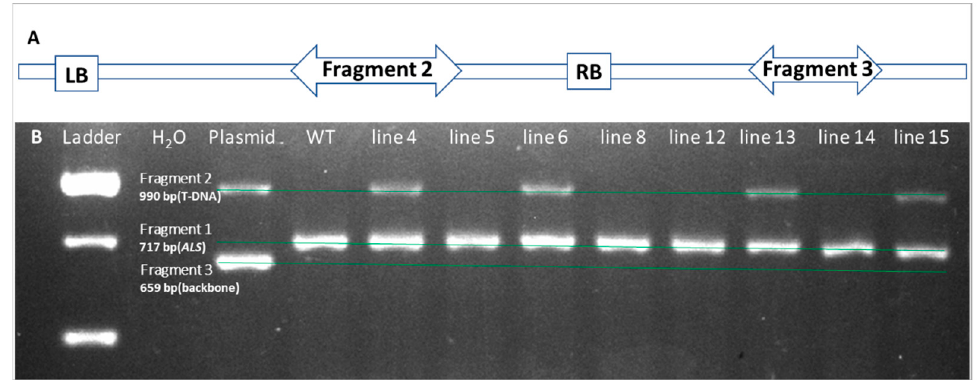
Figure 4. PCR confirmation of transgenic shoots of ‘Carrizo’ citrange based on the histochemical staining of GUS activity. ( A ) Two sets of PCR primers to amplify a T-DNA region (Fragment 2) and a backbone region (Fragment 3) used to confirm GUS positive shoots are transgenic. ( B ) Gel electrophoresis analysis of PCR products to confirm stable incorporation of transgenes into the citrus genome. The presence of both Fragment 1 and 2 and the absence of Fragment 3 were indicative of transgenic (Shoot lines 4, 6, 13, and 15). The presence of only fragment 1 was indicative of non- transgenic (Shoot lines 5, line 8, 12 and 14). Lane 1: Ladder. Lane 2: blank control (H 2 O as PCR template). Lane 3: positive control (plasmid as PCR template). Lane 4: negative control (WT citrus genomic DNA as template). Table 2. Transgenic Plants Confirmed by PCR 1 .